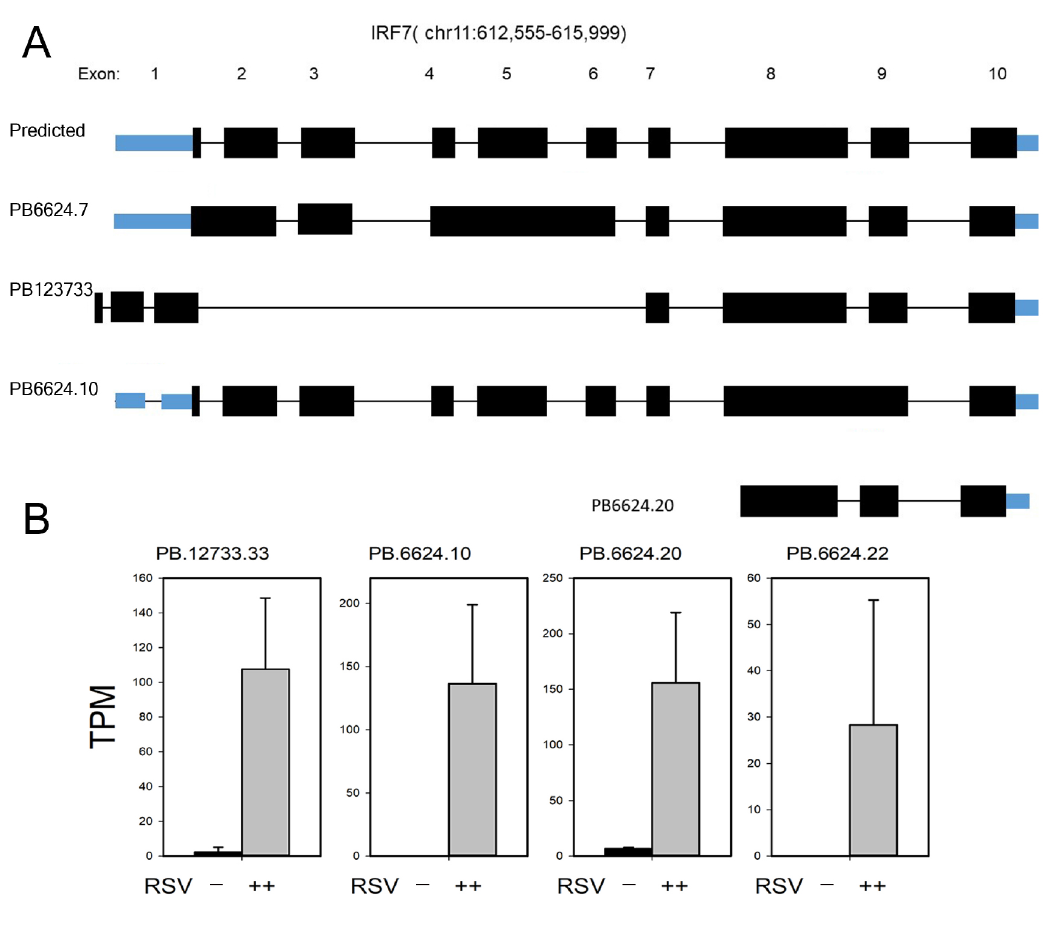
Figure 9. Annotation and expression of IRF7 AS forms. ( A ) Transcript annotation of IRF7. Exons are numbered at the top, relative to the RefSeq annotation; genomic coordinates are indicated. Coding exons are indicated in black; noncoding exons are indicated in blue. PacBio sequence identifiers are at the left. PB123733, PB6624.10, and PB6624.20 are novel transcripts. ( B ) Quantitation of the most abundant IRF7 transcripts from short-read RNA sequencing. Data are presented as transcripts/million (TPM). Note that RSV infection induces major isoform